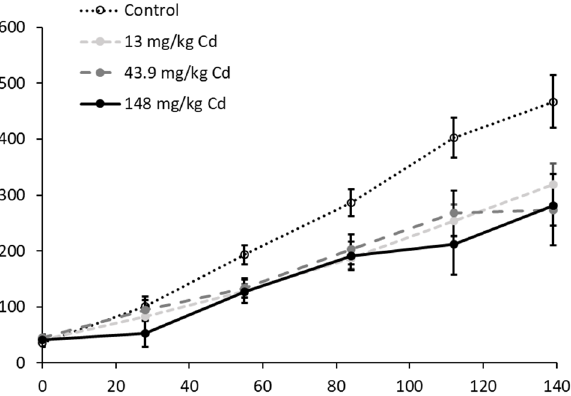
Figure 2. Mean ± SD weights (mg) of L. rubellus exposed to a control and three concentrations of Cd from a young juvenile stage throughout development for 140 days.